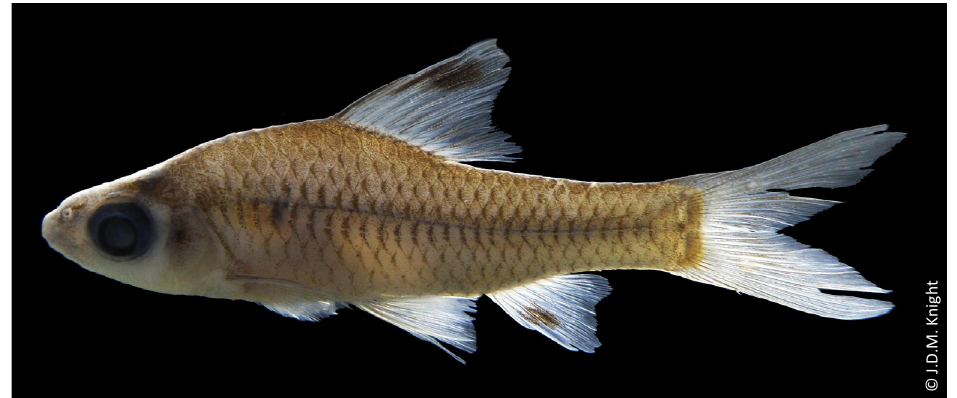
Description: See Table 1 for morphometric characters and meristics, and Images 1 & 2A for general appearance.